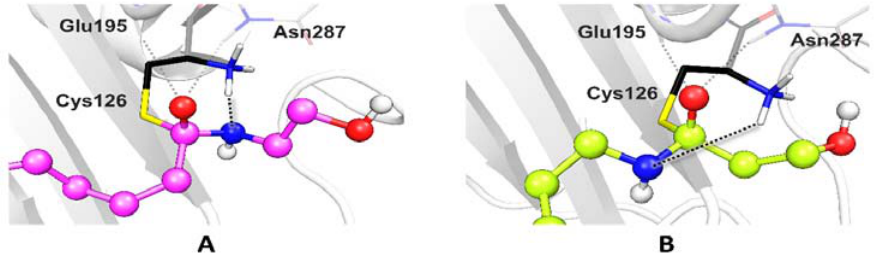
Figure 5. Comparison of the docking poses of PEA ( A ) and RePEA ( B ) into the NAAA pocket. In both cases, the oxyanion hole (Glu195 and Asn287) interacts with the negatively charged oxygen atom of the ligand. By reverting the amide bond, however, effective interaction between the NH 3+ terminal of Cys126 and the leaving group of the ligand is hindered.